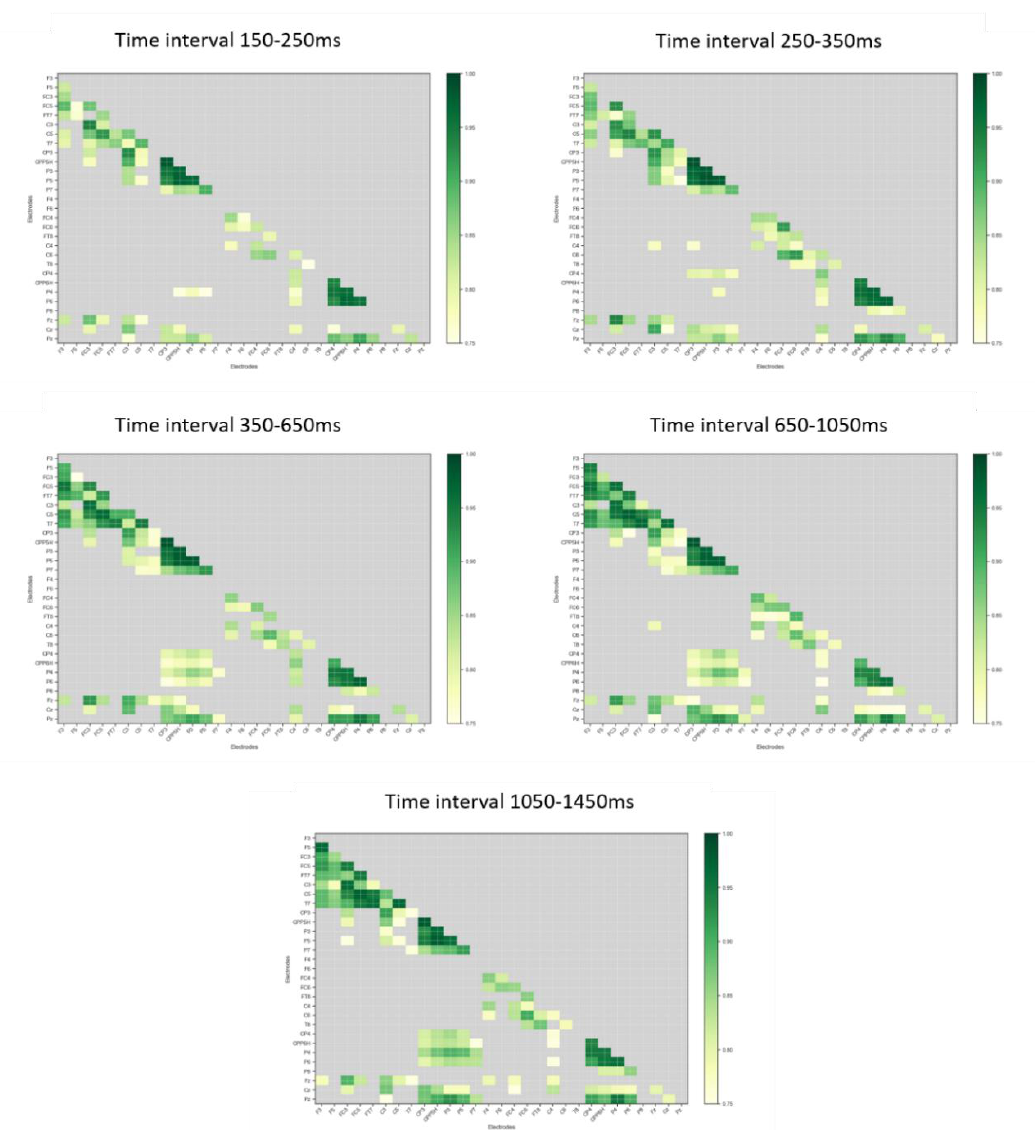
Figure A5. Selection of regions of interest (ROIs) based on correlation matrices of EEG electrodes for each selected time window at the baseline level (pretest). Pearson correlation with a clipping level r (avg) = 0.75.